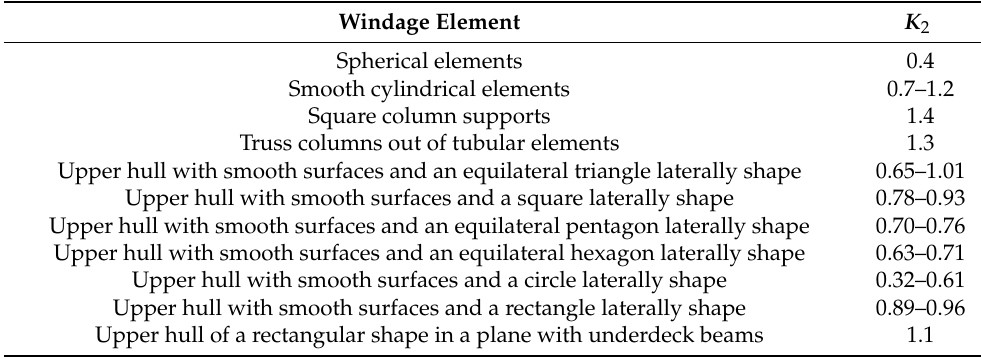
Table 6. The form drag coefficient for the loads’ calculation from wind